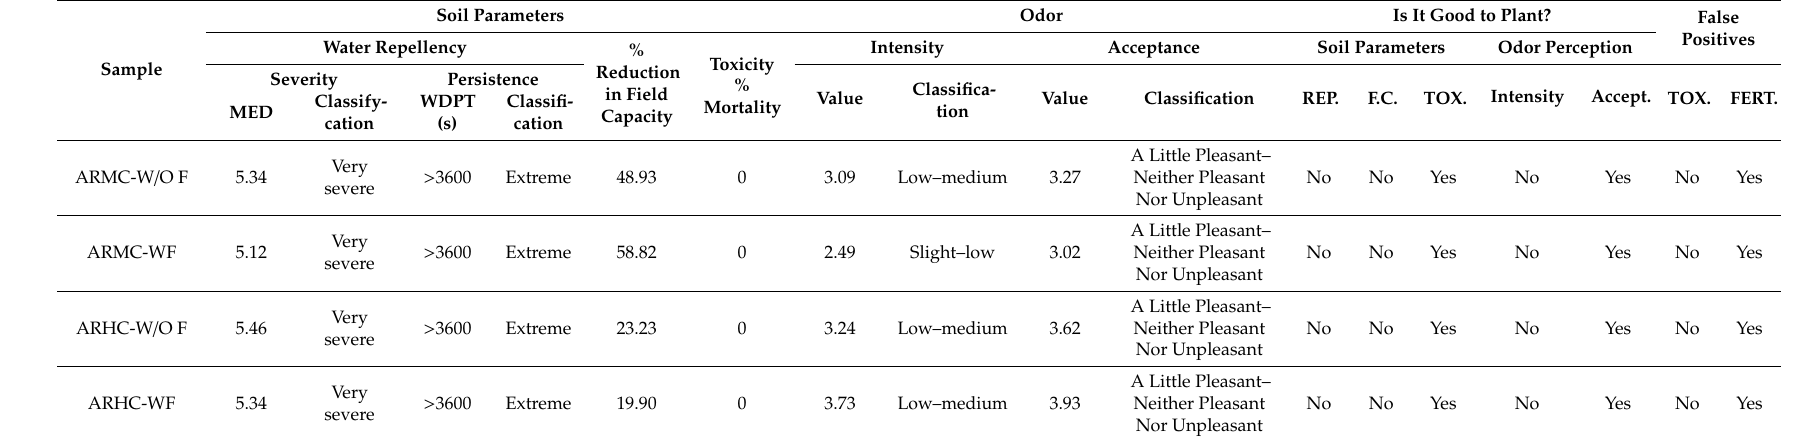
Table 6. Evaluation: when they say “it is good to plant”, is it really